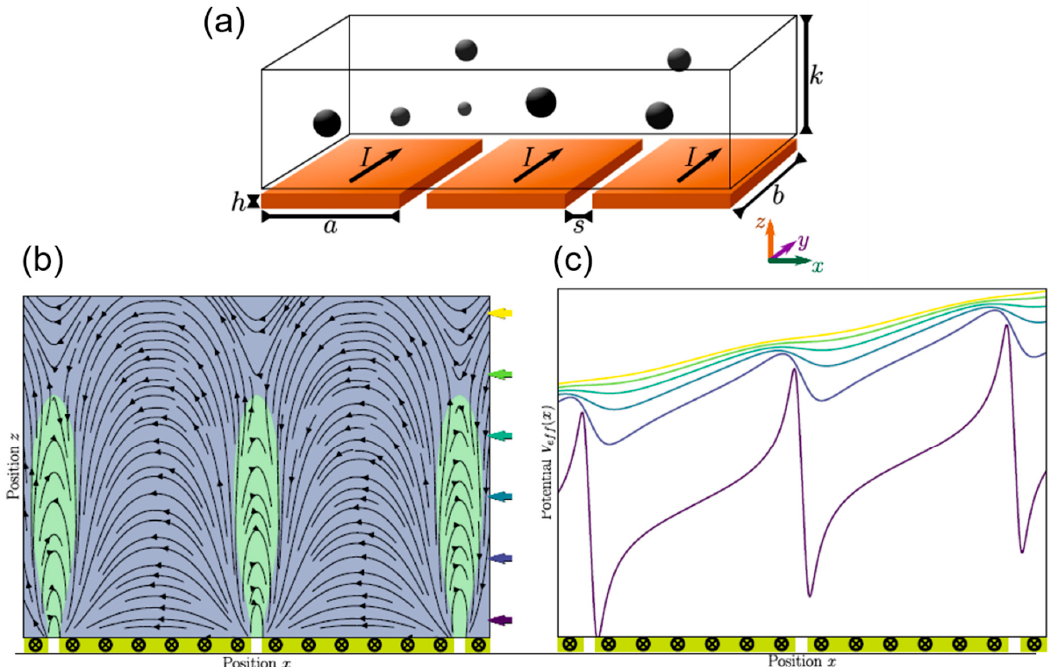
Figure 10. Magnetic on–off ratchet according to [22]; ( a ) A microfluidic channel of width b and height k, under which a series of conductors of width a and thickness h are located at a distance s. Experimentally, a fixed channel height can easily be realized by closing the channel in z -direction using a glass cover; ( b ) x-z cross-section through the force field (F x , F z ), represented by the streamlines, with F x > 0 and F x < 0 ( c ) Line section at constant height through the potential landscape, the z-coordinate corresponds to the colored marking by the arrows in ( b ). The tilting of the potential is only present for very short ratchets, i.e., only a few current paths, and disappears when the ratchet consists of many current paths.